Question: Briefly state, in one sentence, what is plotted here.
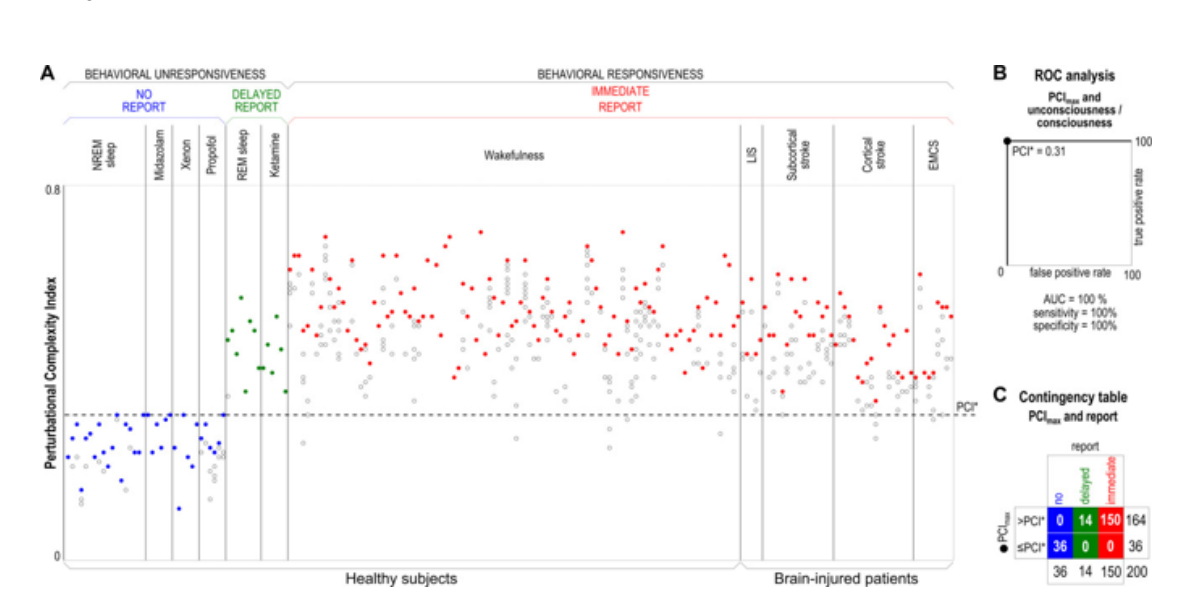
Answer: (A) The circles represent the Perturbational Complexity Index (PCI) values derived from cortical responses to transcranial magnetic stimulation (TMS) across various brain stimulation sites. These values are sorted by age and condition, reflecting different states of consciousness, such as non-REM sleep, anesthesia, dreaming, and wakefulness. The solid circles denote the highest PCI value (PCImax) for each individual, while open circles represent lower PCI values. (B) The Area Under the Curve (AUC) is 100%, indicating excellent discriminatory power. Using PCI as the cutoff, both sensitivity and specificity achieve 100%, demonstrating the accuracy of this cutoff in identifying conscious states. (C) The contingency table is created by dividing the PCImax values using the PCI∗cutoff, as illustrated by the dashed horizontal line in panel A. This table categorizes different states, such as emergence from a minimally conscious state (EMCS), locked-in syndrome (LIS), and rapid eye mo